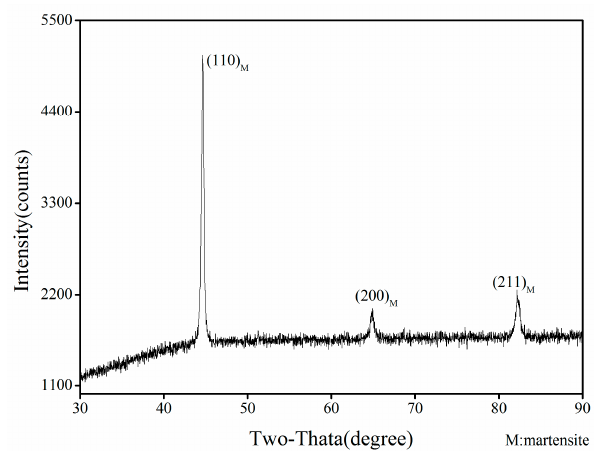
Figure 5. X-ray diffraction diagram of center seam.